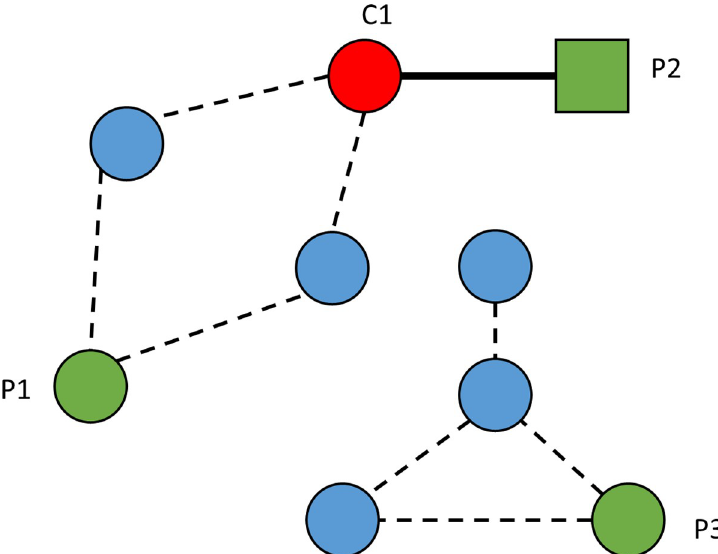
Fig 3. Description of close-proximity interactions (CPIs) and determination of their distances through combined weekly carriage data and CPI-network plots. Circles and rectangles (nodes) represent patients. The red circle C1 represents a case with an incident-colonization episode. Green circles and rectangles P1, P2, P3 represent transmission candidates, who were colonized with the most similar isolate during the preceding 4 weeks. Patients P1 and P2 are potential infectors, as they are connected to the incident case via edges in the CPI network. The closest potential infector is patient P2 (represented by a rectangle). The distance is 1 because no intermediary is present between C1 and P2 (solid black line). Blue circles represent individuals susceptible to